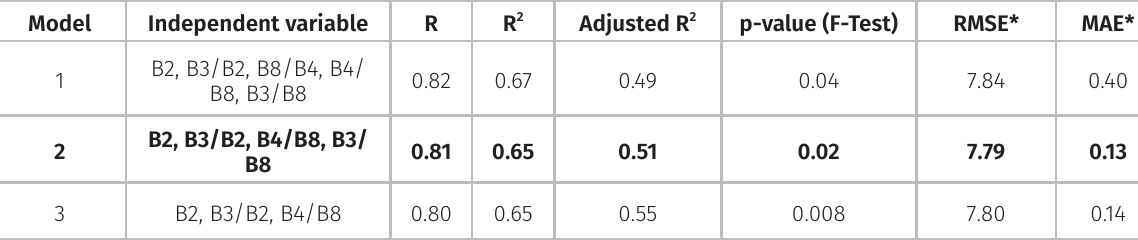
Table V. Statistics of Chl- a estimation models.